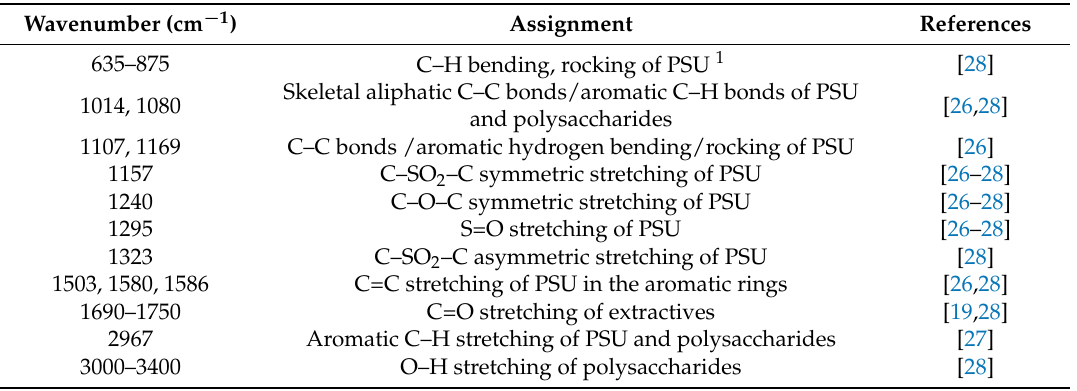
Table 3. Assignment of attenuate total reflectance-FTIR bands.